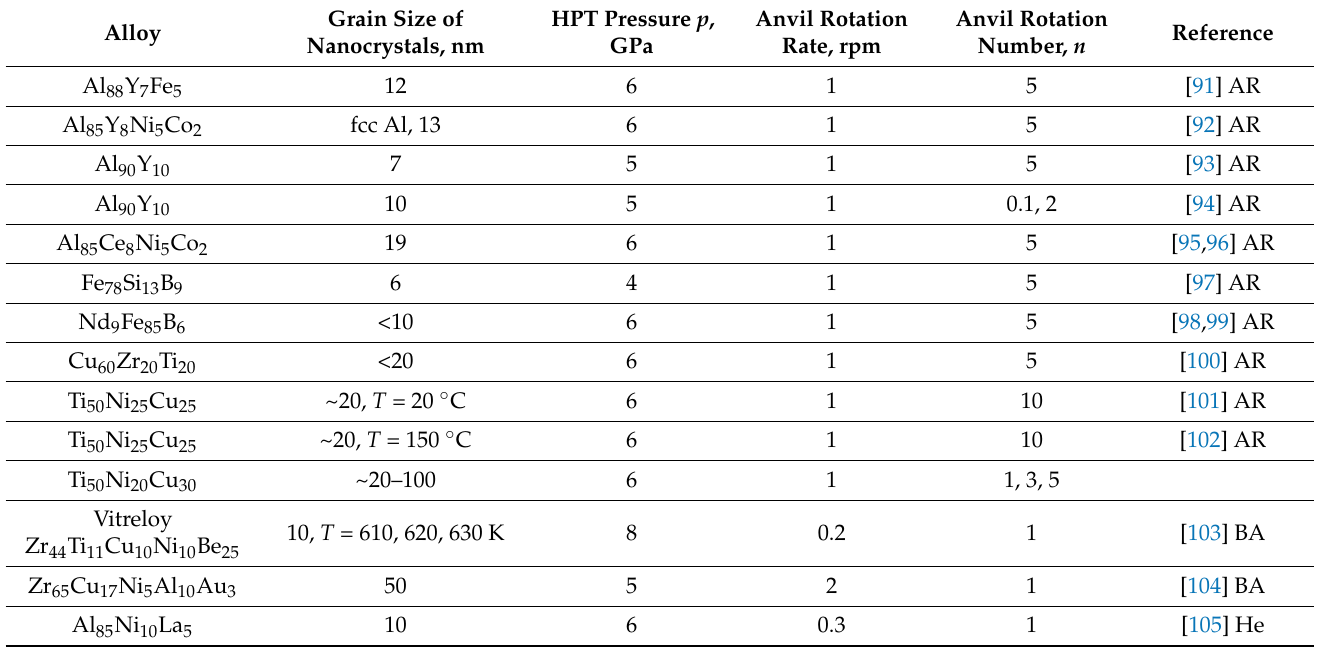
Table 1. Nanocrystallization during HPT of amorphous ribbons (AR), bulk amorphous alloys (BA), and helium gas atomized sampl (He).